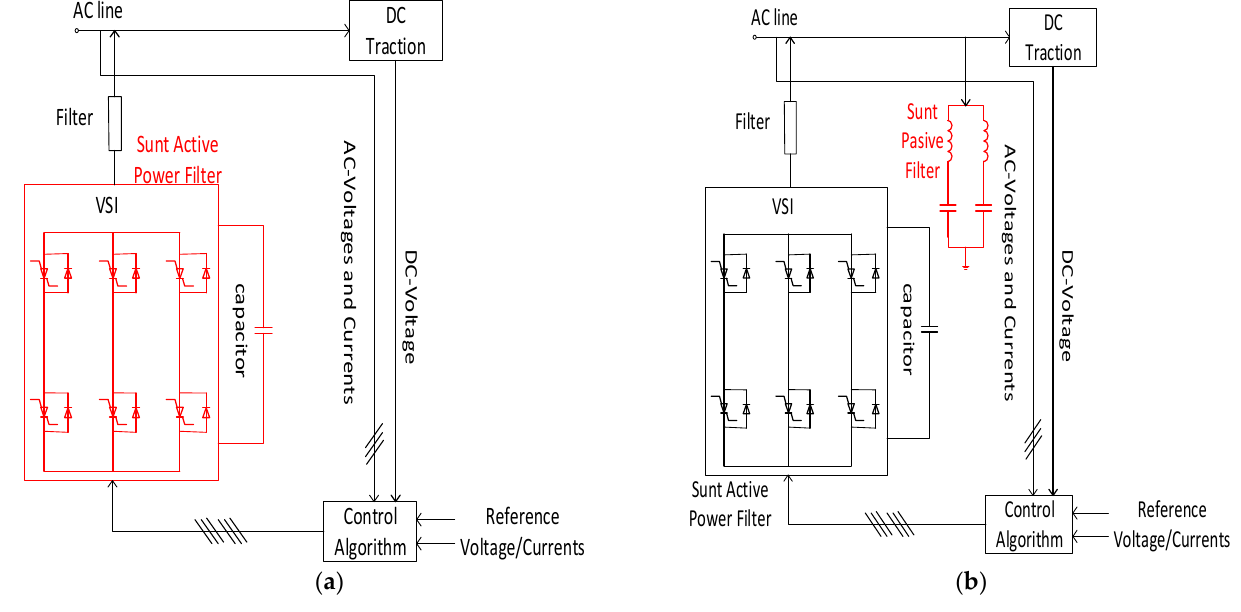
Figure 14. Shunt active power filter: ( a ) simplified model [122], ( b ) hybrid version [123].